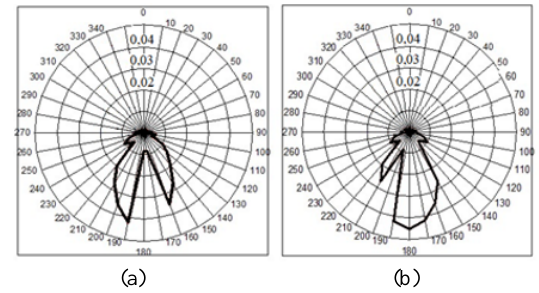
over a cylinder 2 2 /|E 0 | |E|